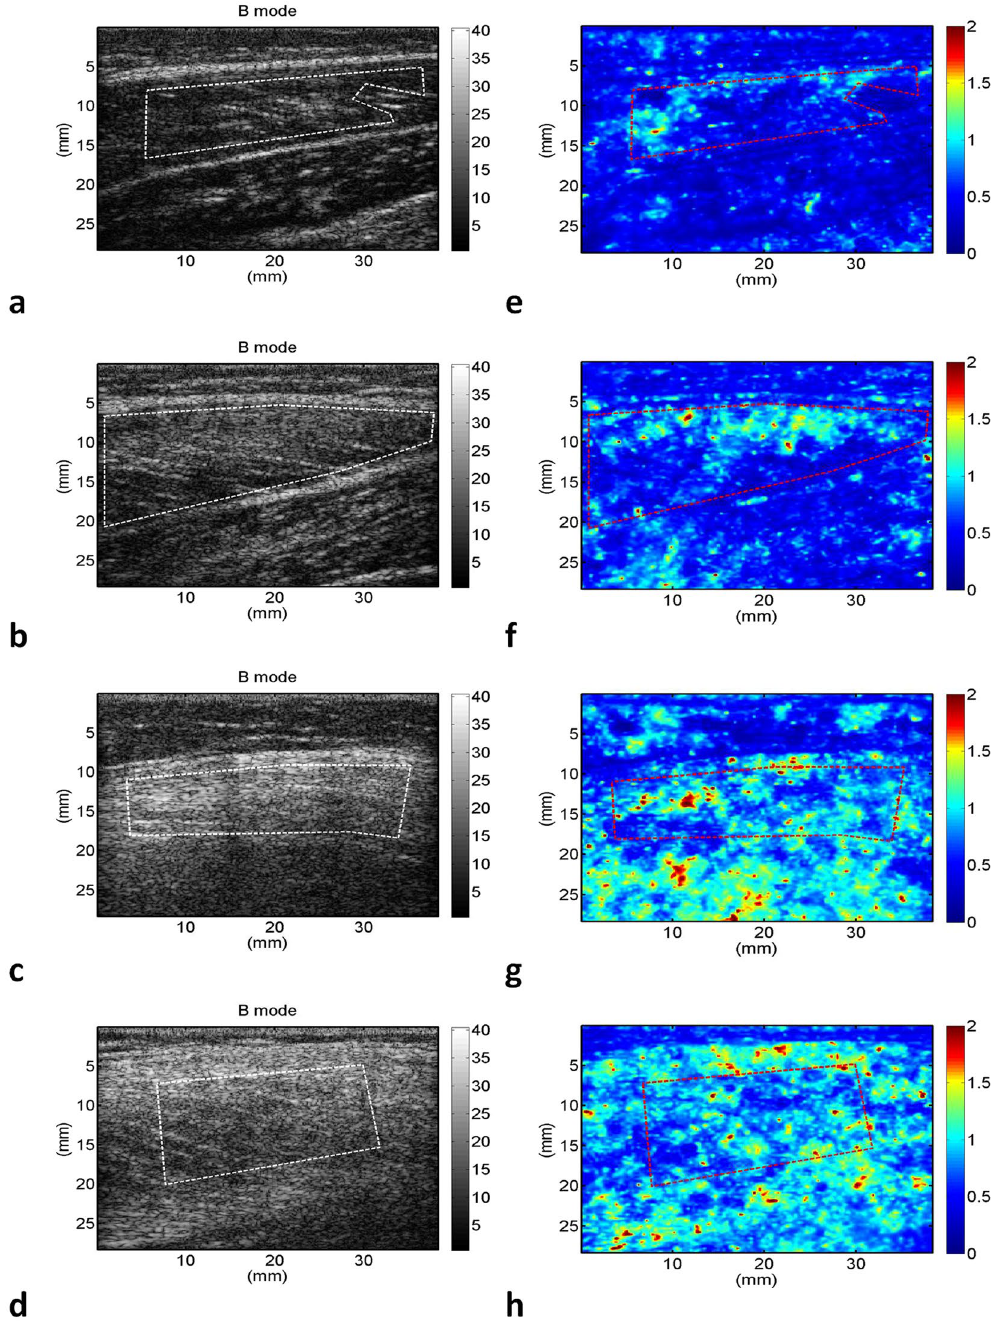
Figure 3. Grayscale B-mode images of the gastrocnemius muscle of the ( a ) controls; ( b ) stage 1 DMD patients; ( c ) stage 2 DMD patients; and ( d ) stage 3 DMD patients. ( e – h ) Corresponding WMC Nakagami images showing an increase in the brightness of the WMC Nakagami image from control to stage